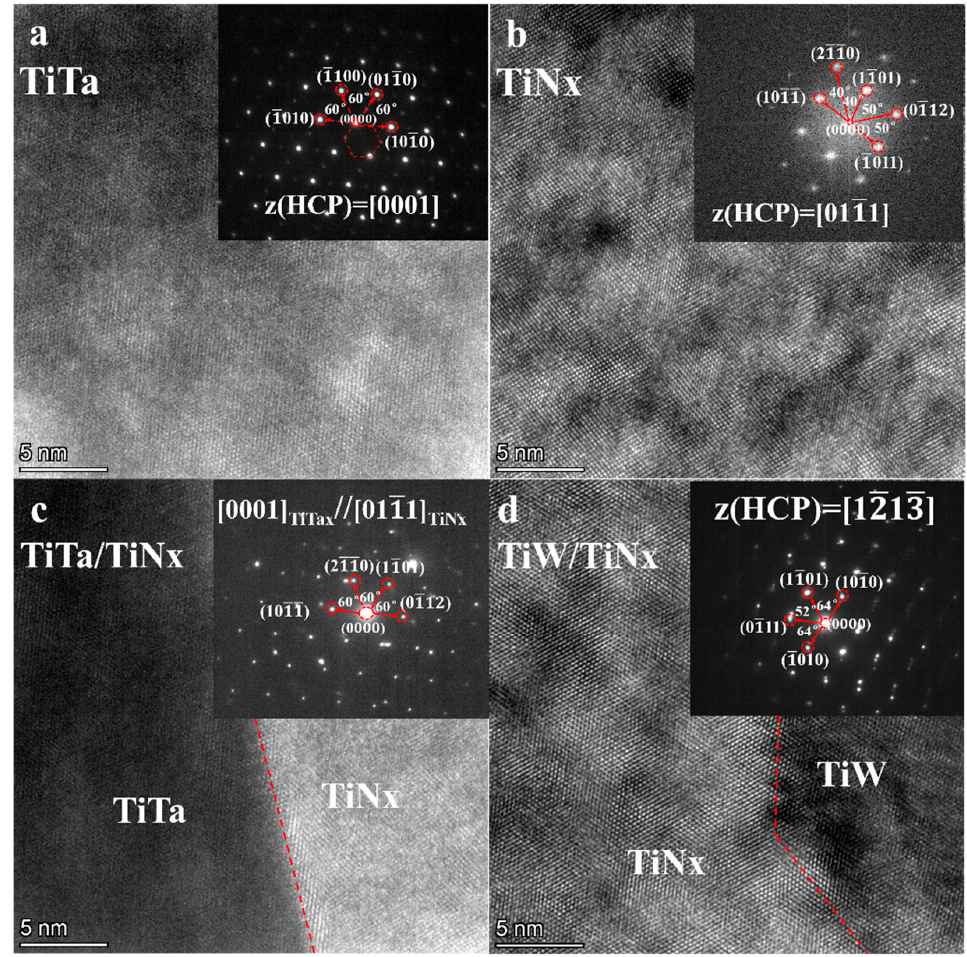
Figure 15. HR-TEM images of W/Ti/TiN/Ta composites after 1200 °C joining and the orientation relationships of the interface: ( a ) TiTa; ( b ) TiNx; ( c ) TiTa–TiNx interface; and ( d ) TiW–TiNx interface.